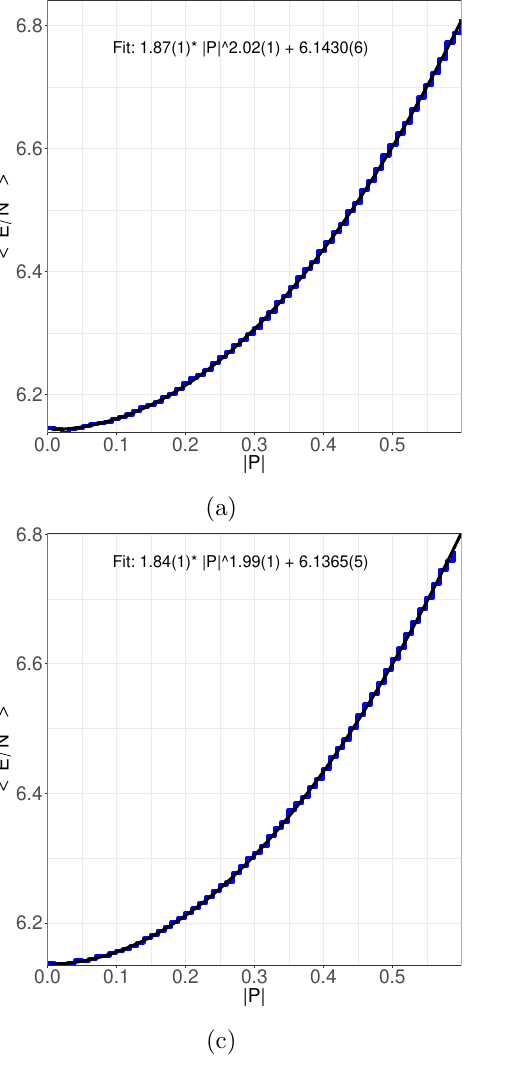
(cid:10) (cid:11) (cid:10) (cid:11) E=N 2 and R 2 . The (cid:12)t to a j P j b + c is done in the range